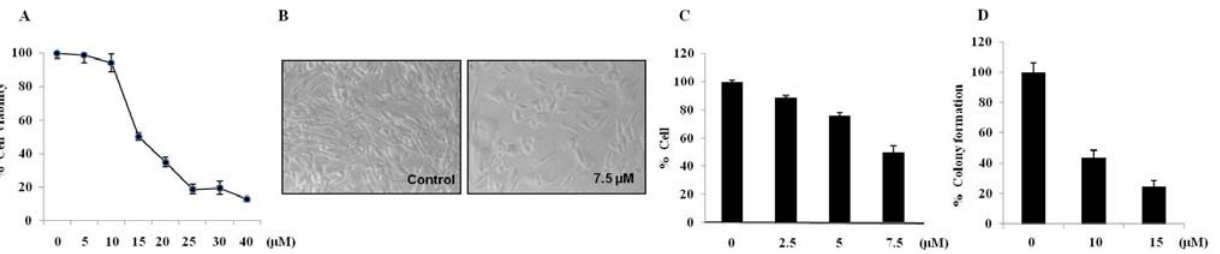
Figure 2. Brazilin inhibits glioblastoma cell growth; Morphological change, growth inhibition, and cytotoxicity in U87 cells. U87 cells were treated with 5, 10, 15, 20, 25, 30, or 40 μ M of brazilin for 24 h, and cell viability was assessed by MTT assay ( A ). Morphological changes were observed using a microscope (magnification, 100×) ( B ). Effect of subtoxic concentrations of brazilin on proliferation of U87 cells. Cells were treated for 72 h with 2.5, 5, or 7.5 μ M brazilin and stained with trypan blue for estimation of cell density ( C ). Incubation with brazilin for 14 days reduced clonogenic potential